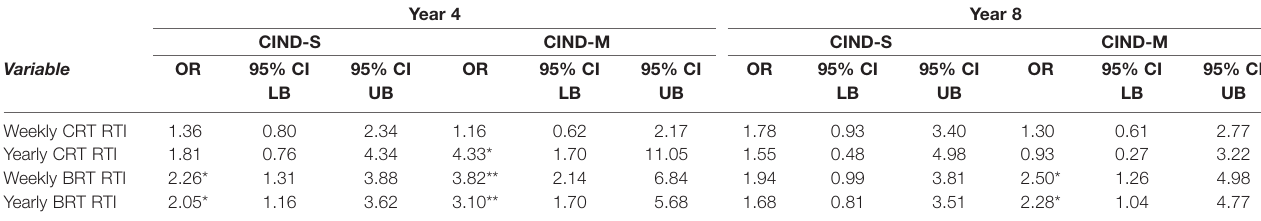
TABLE 3 | Multinomial logistic regression: weekly and annual RTI in relation to the likelihood of cognitive impairment status at Year 4 and Year